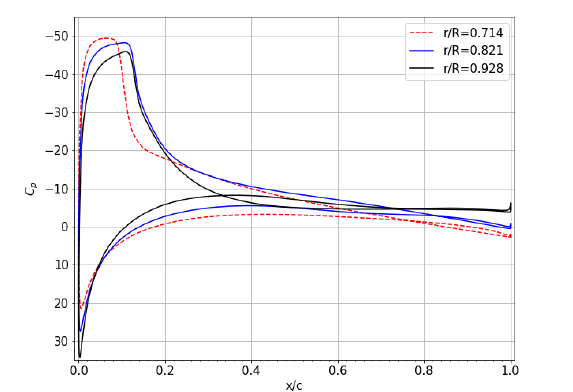
Figure 7. Pressure coefficient of a slice on the blade at radial position r / R = 0.714, 0.821 and 0.928, azimuth angle Ψ = 90 ◦